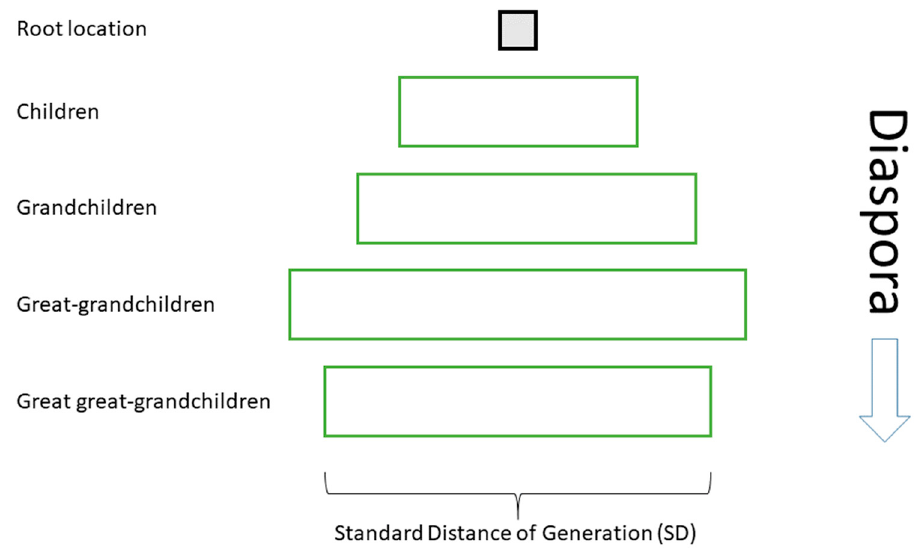
Figure 1. Generational Migration Pyramid (derived from Otterstrom and Bunker 2013, p. 547).